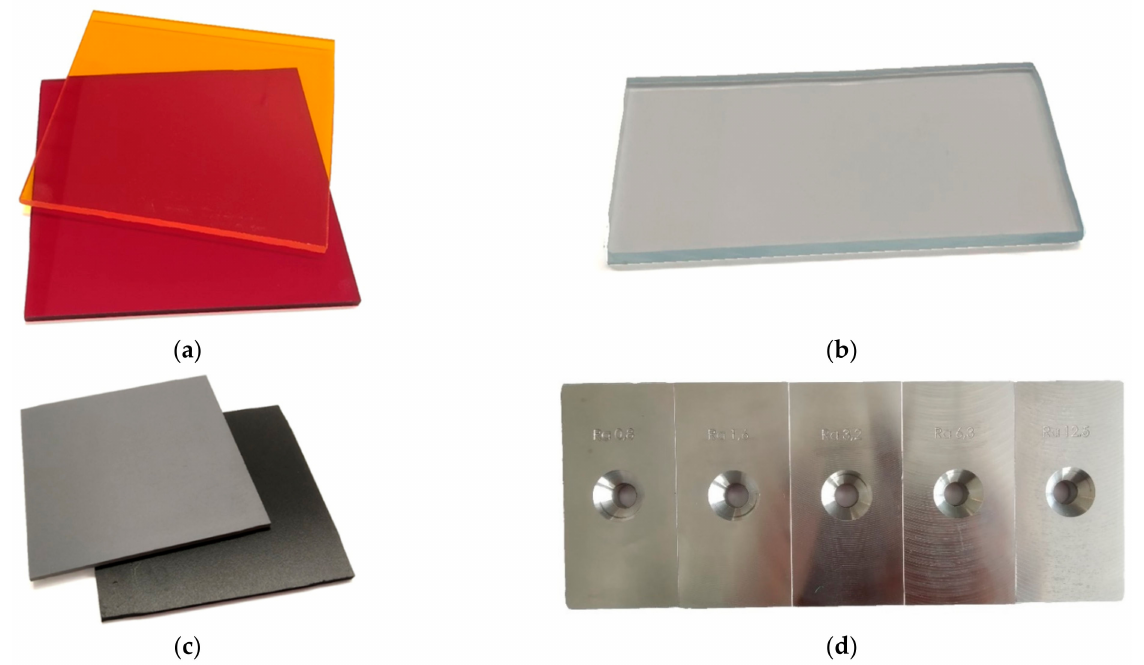
Figure 8. Scanned samples: ( a ) Transparent colored plastics (acrylic sheets); ( b ) transparent pure plastic (acrylic sheet); ( c ) non-transparent colored plastics (PVC plastics); ( d ) aluminum alloy with different roughness (Ra0.8–12.5).